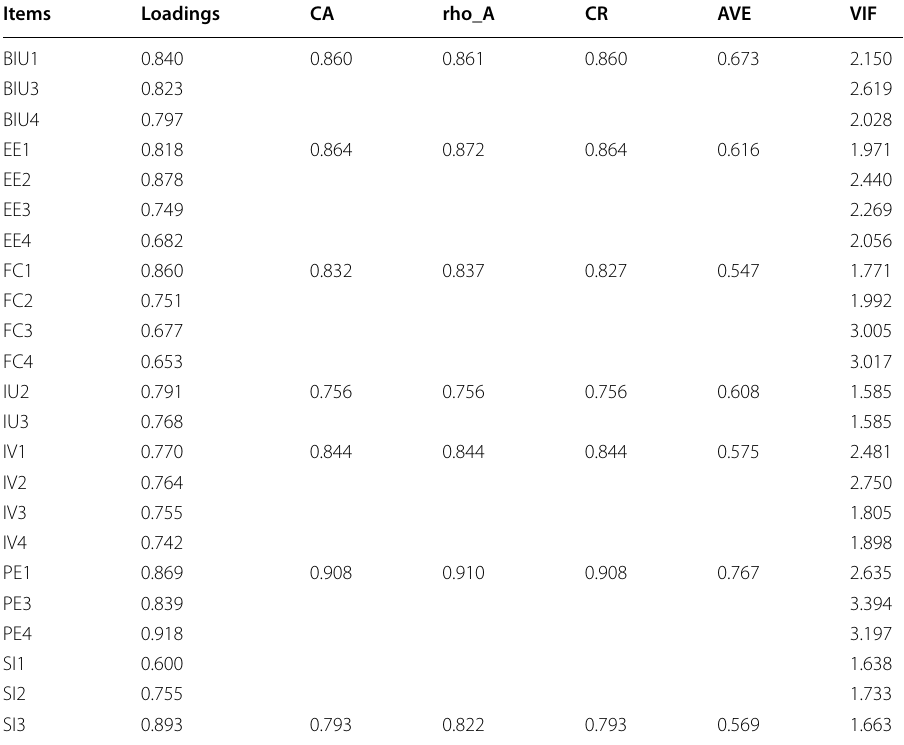
Table 1 Convergent validity (Loadings, CA, CR, AVE, and VIF)